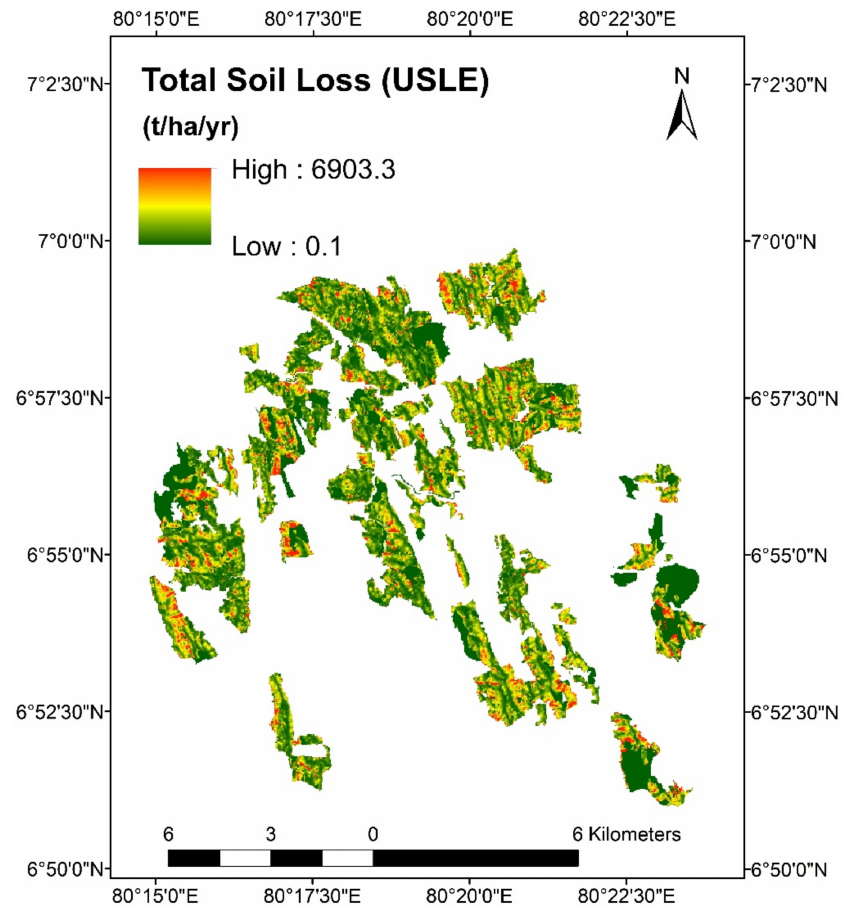
Figure 7. Total soil loss (USLE) map of the study